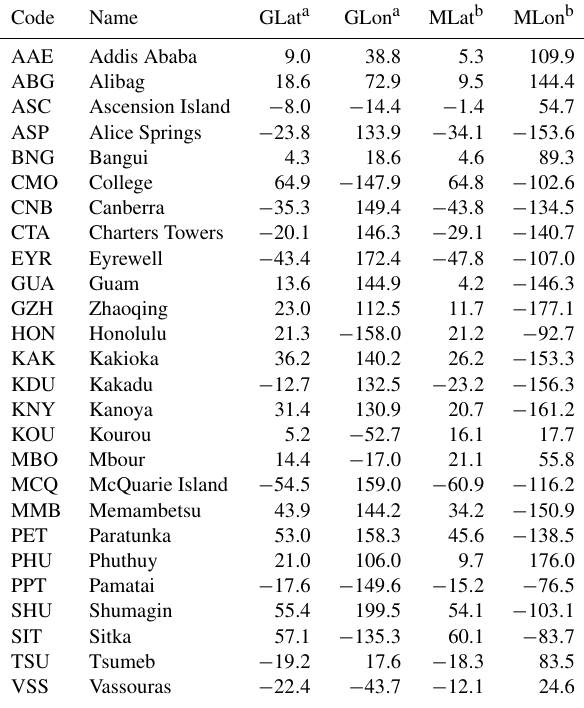
Table 3. Locations of magnetic stations in geographic and geomag- netic